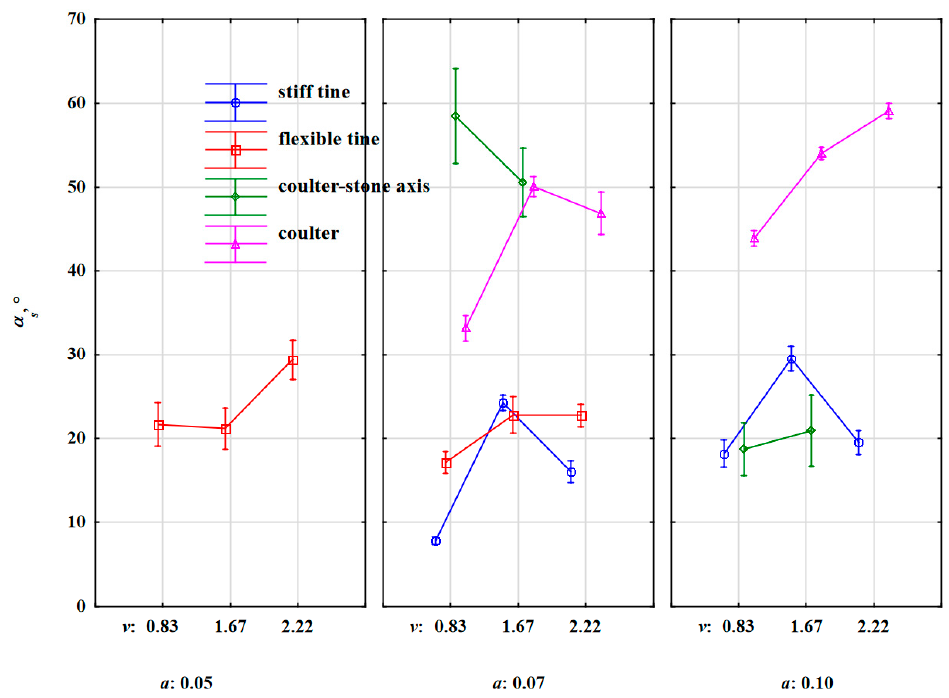
Figure 12. The angle for stone movement relative to the direction of the tool movement α s under the extortions of the stiff tine, flexible tine, coulter-axis stones and coulter working at varied depths and working speeds.